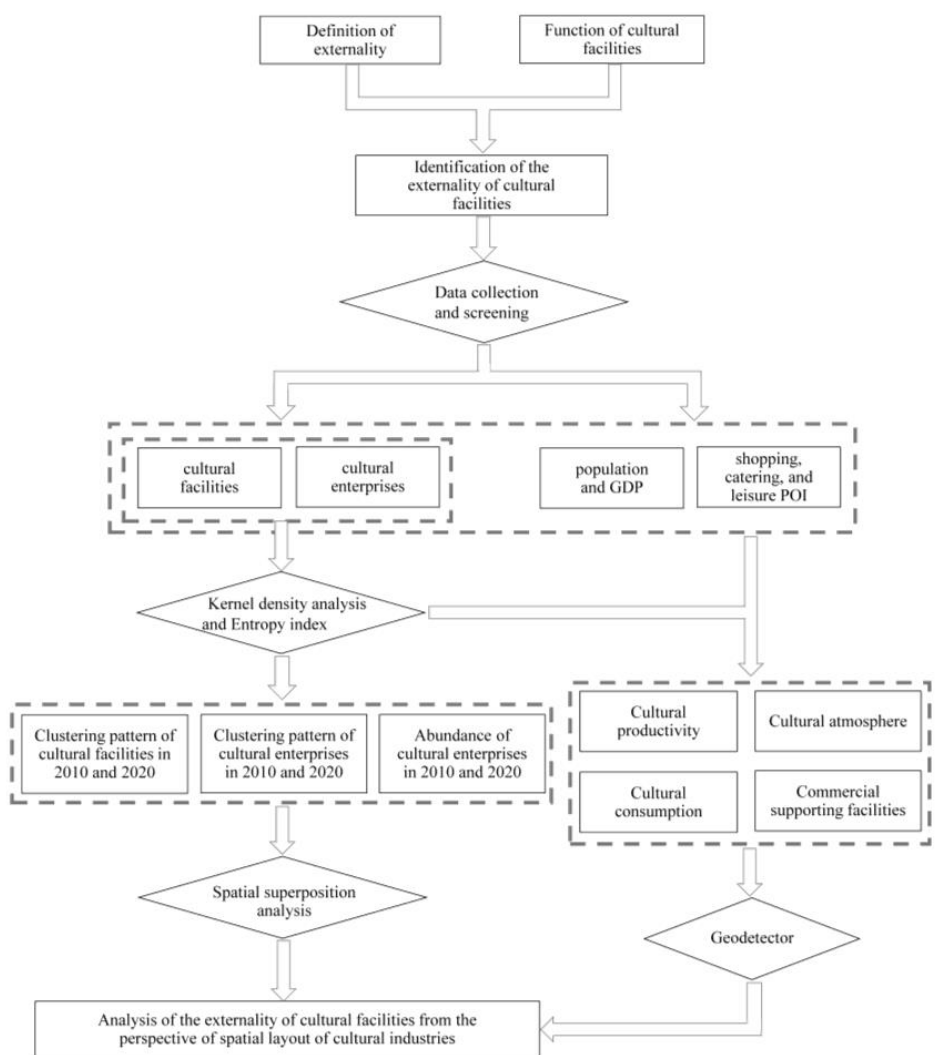
Figure 1. Technical route of the externality assessment of cultural facilities.